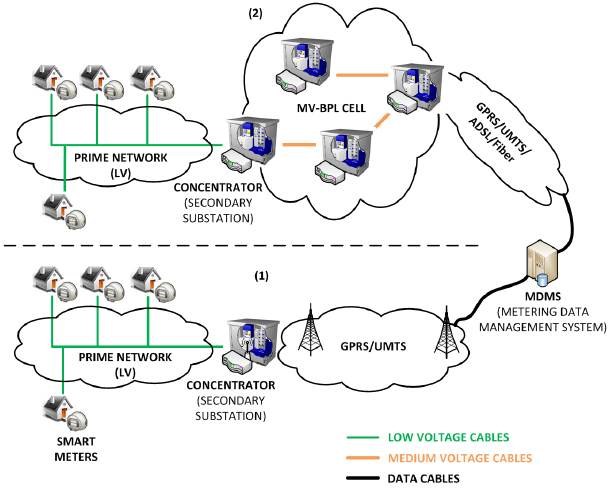
Figure 1. Overview of the M2M communications network deployed in the pilot scheme of the OSIRIS (Optimisation of Intelligent Monitoring of the Distribution Network) project. LV, Low Voltage; MV, Medium Voltage; BPL, Broad Band Powerline; MDMS, Metering Data Management System. Both Configurations (1) and (2) used PRIME (Poweline Intelligent Metering Evolution) as the last mile communications technology. PRIME is a second-generation NB-PLC (Narrowband Power Line Communication) standard that uses the low voltage cable as a communications medium